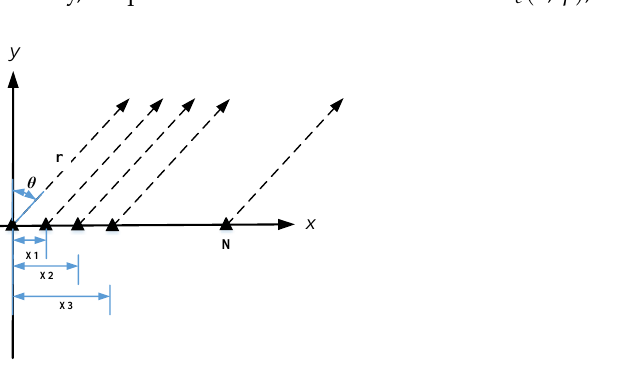
Figure 3. N -element linear array.